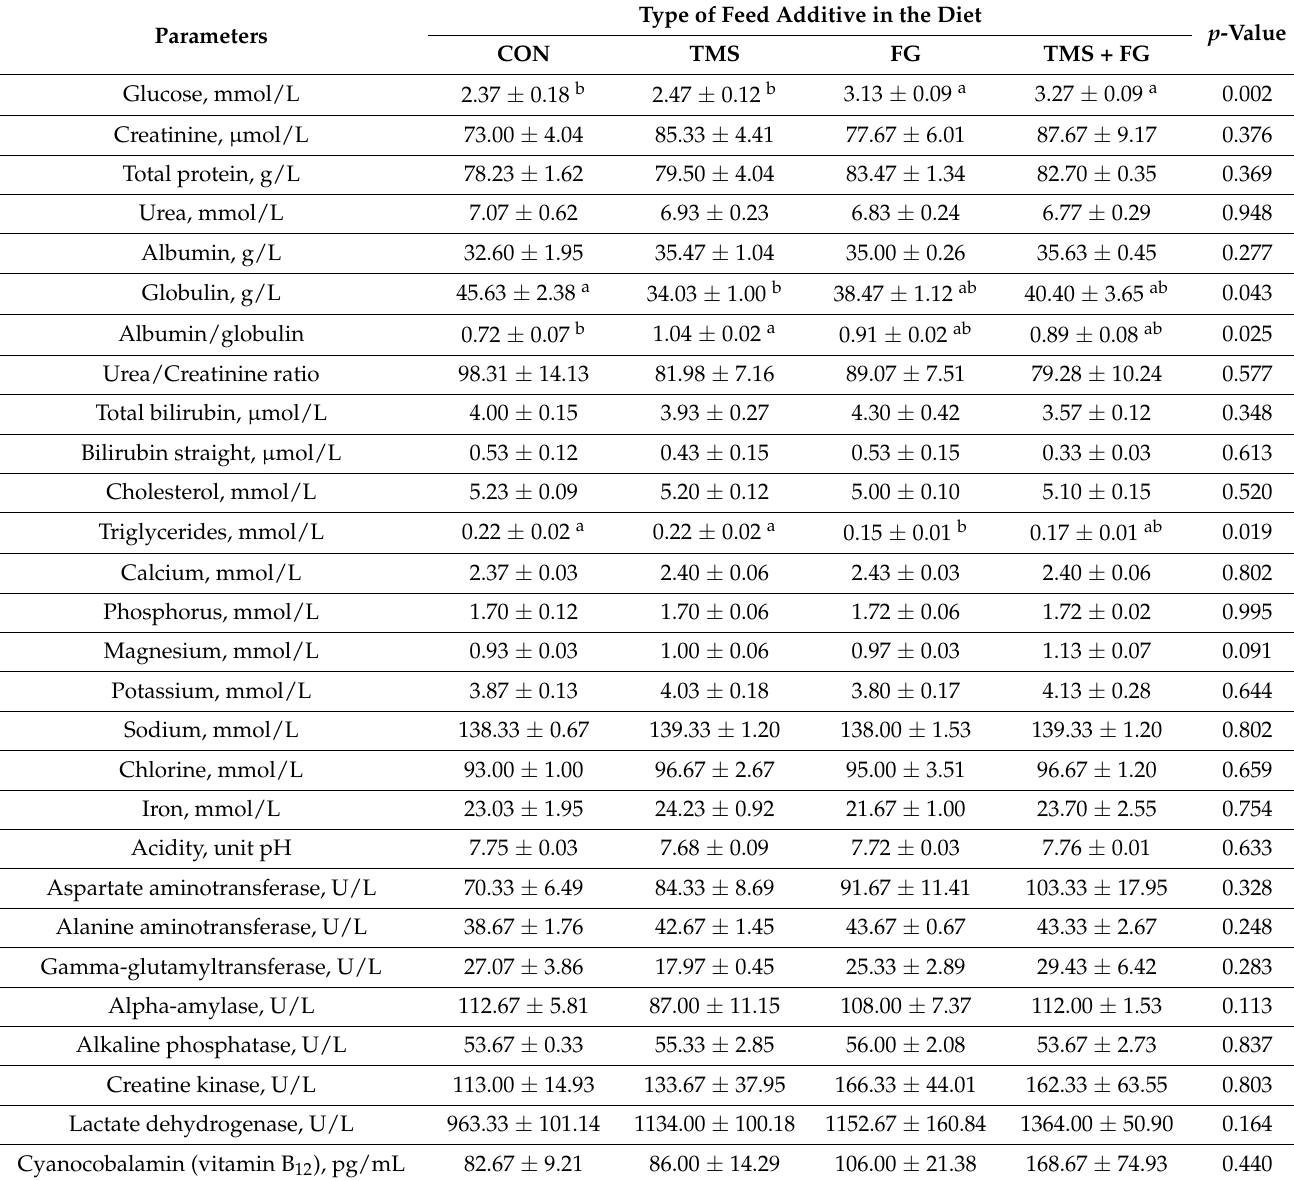
Table 9. Blood biochemical parameters of Suksun dairy breed (90